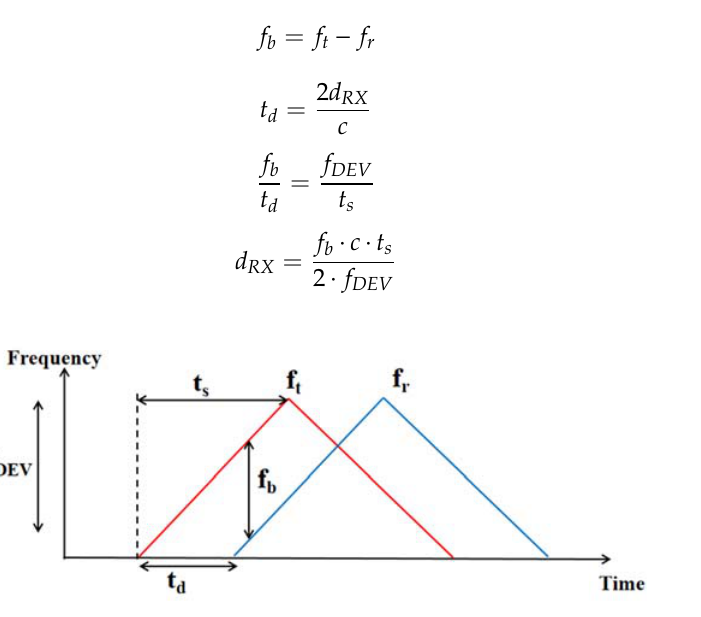
Figure 9. Principle of FMCW chirp